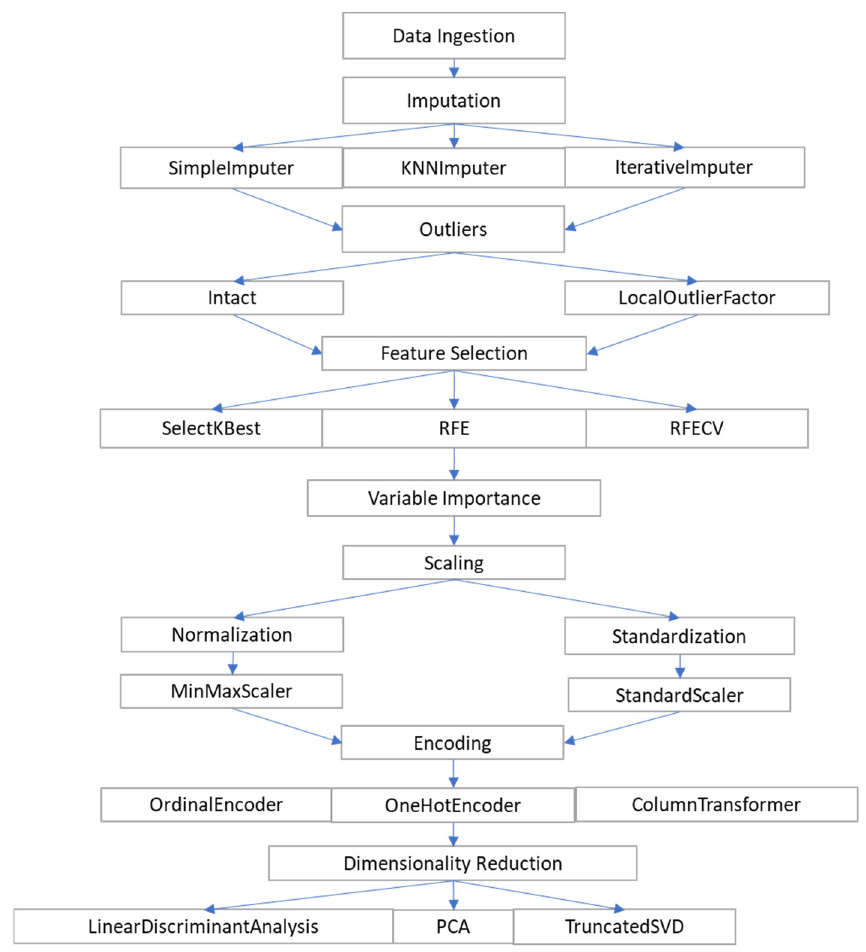
Figure 4. Scikit-Learn’s data pre-processing flow.